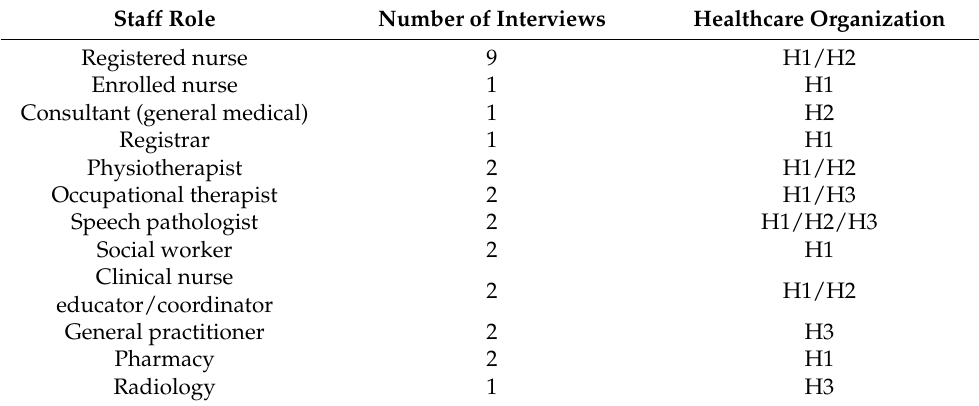
Table 2. Staff participation list for